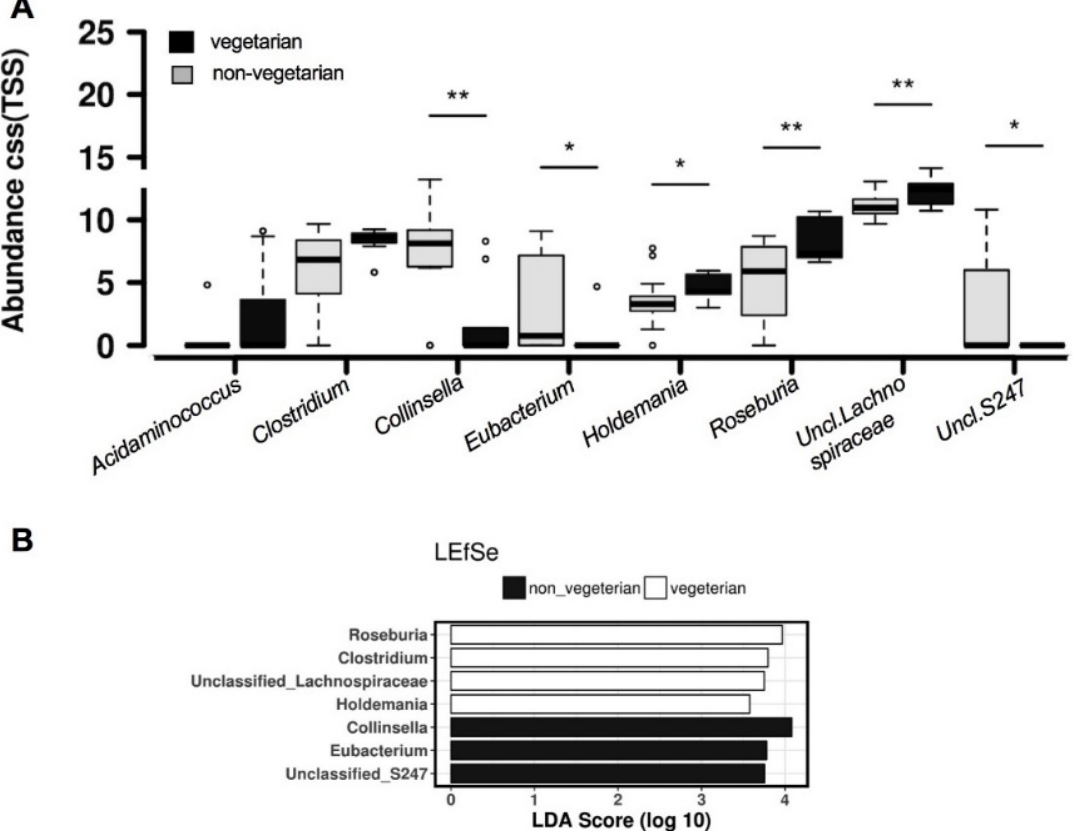
Figure 2. Linear discriminant analysis (LDA) effect size (LEfSe) analysis, ( A ) Abundance, Box plots show the 2.5th and 97.5th percentile with a line at the median; ( B ) LDA Score. *, p < 0.05; **, p < 0.01; º, individual values <2.5th or >95th percentile.